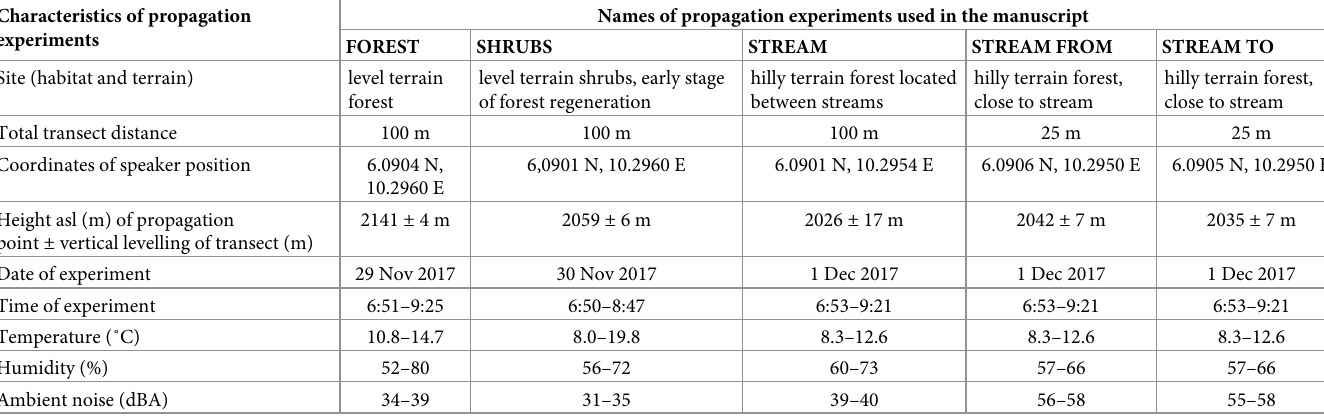
Table 1. Characteristics of propagation experiments with the Yellow-breasted Boubou ( Laniarius atroflavus ). Characteristics of propagation